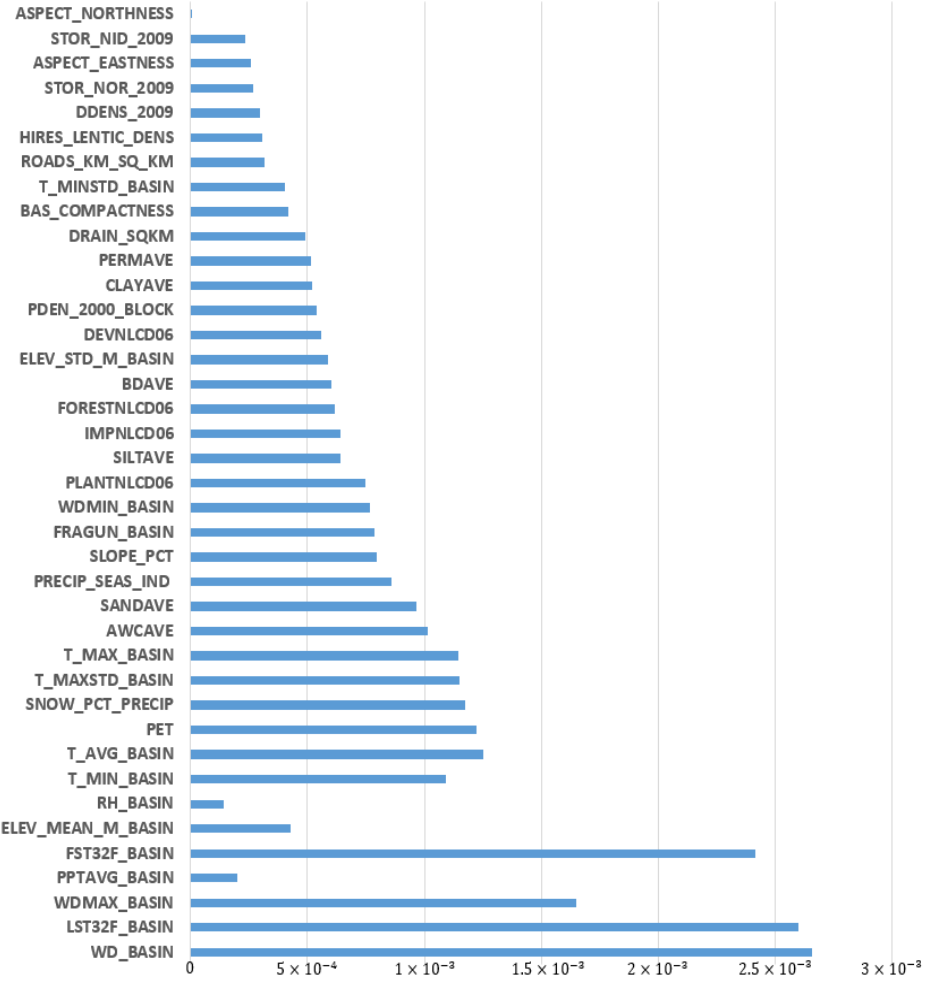
Figure 8. Predictor variables of the shape parameters (with associated importance) for all sites across different physiographic regions. Description of predictor variables is provided in Appendix A. Table 3. Common predictor variables across all study regions. Description of predictor variables is provided in Appendix